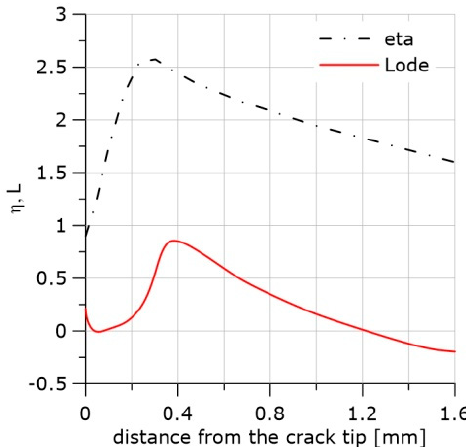
Figure 17. Distributions of the η and Lode functions in front of the crack at the crack centre at the moment when the loading was stopped; specimen PR and the material softening option, material HW, temperature +20 °C.